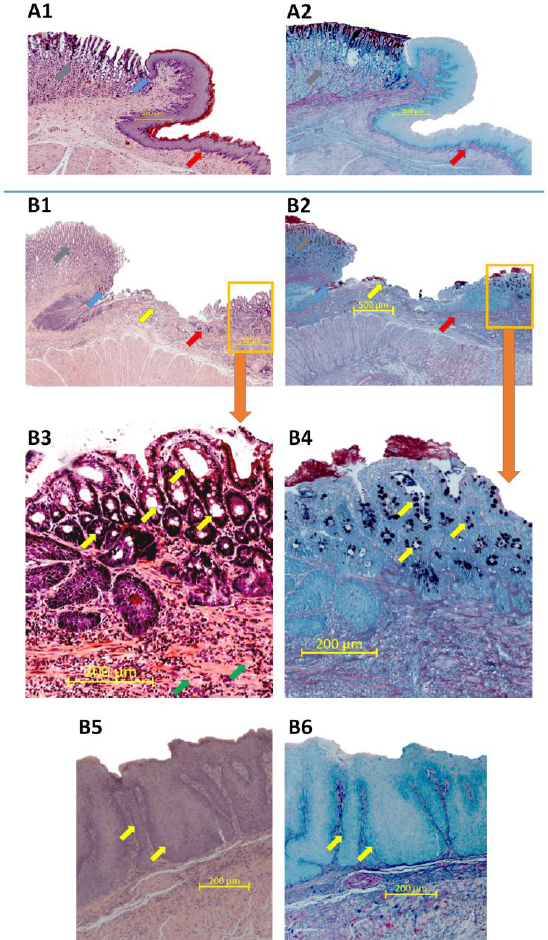
Figure 7. Microscopic appearance of esophageal mucosa, gastroesophageal junction (GEJ) and gastric cardia stained with haematoxylin / eosin (H&E) or alcian blue / periodic acid-Schi ff (AB / PAS) in representative rats without ( A1 , A2 ) or with an esophagogastroduodenal anastomosis ( B1 – B6 ). Greyarrowpointsoutgastricmucosa, bluearrowpointsoutGEJ,redarrowindicatesesophagealmucosa, yellow arrow indicates esophageal ulceration, orange frame shows Barrett’s-like lesions ( A1 , A2 , B1 , B2 ). ( B3 , B4 ) show high resolution images of Barrett’s-like lesions where yellow arrows indicate goblet cells and green arrows indicate fibrosis. Yellow arrows indicate epithelial hyperplasia ( B5 , B6